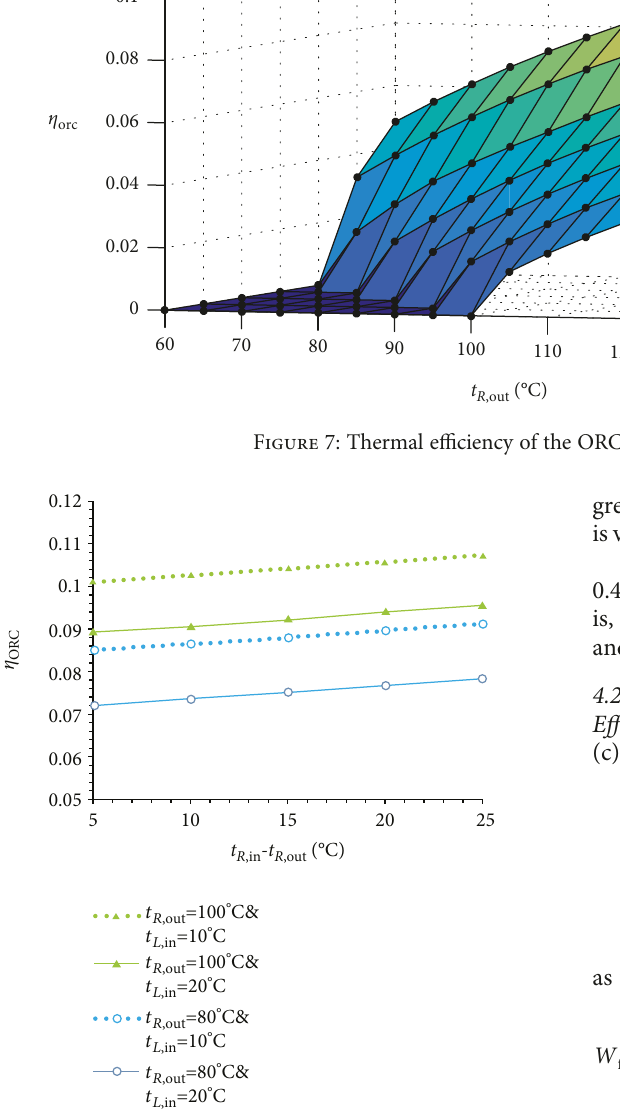
Figure 8: Thermal e ffi ciency of the ORC subsystem along with the temperature di ff erence of thermal fl uid inlet and outlet of the